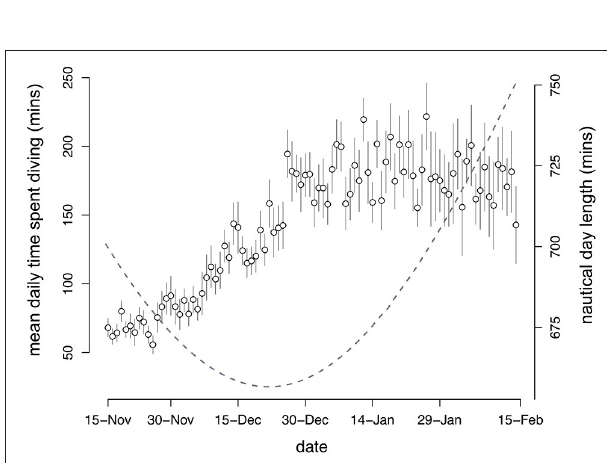
FIGURE 3 | Mean (SE) daily dive effort (minutes) by Common murres ( n = 17) in winter (15 Nov − 15 Feb). Continuous line (dashed gray) shows day length (minutes) at 47.6 ◦ N from nautical sunrise to nautical sunset. Linear mixed model output for differences in mean daily dive effort during EW (95.2 ± 5.6min; 95% CI: 84.2–106.3min) and LW (178.3 ± 6.3min; 95% CI: 165.9–191.0min).